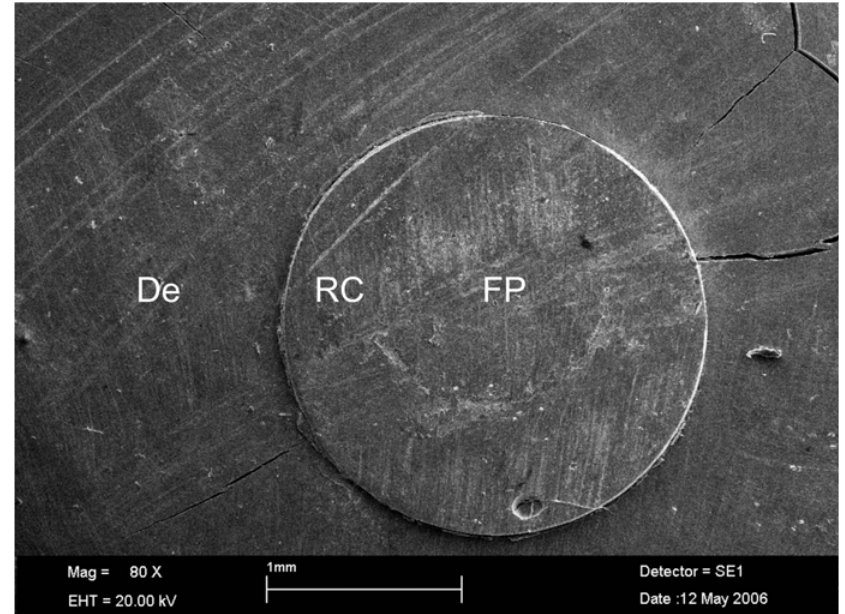
FIGURE 1- Non-relined fiber post specimen after the push-out test. Note that debonding occurred between the resin cement and the dentin. Dentin (De), Fiber-post (FP) and Resin cement (RC)